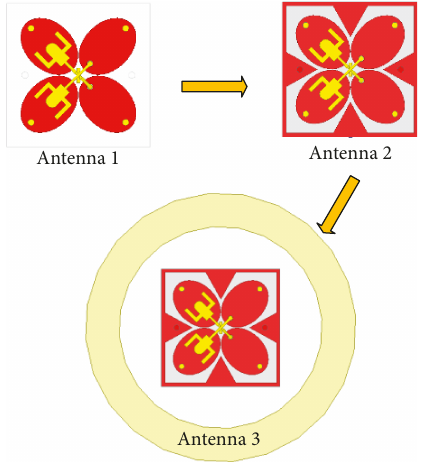
Figure 3: The design process of the proposed antenna.